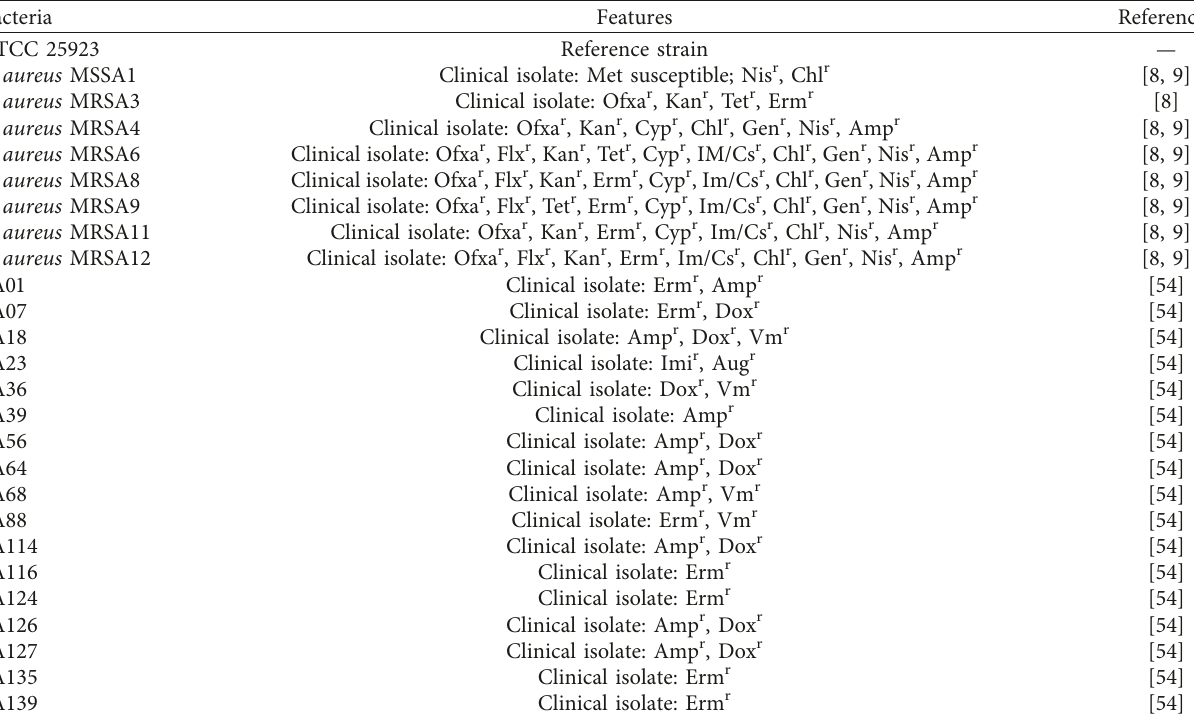
Table 2: Bacterial strains and